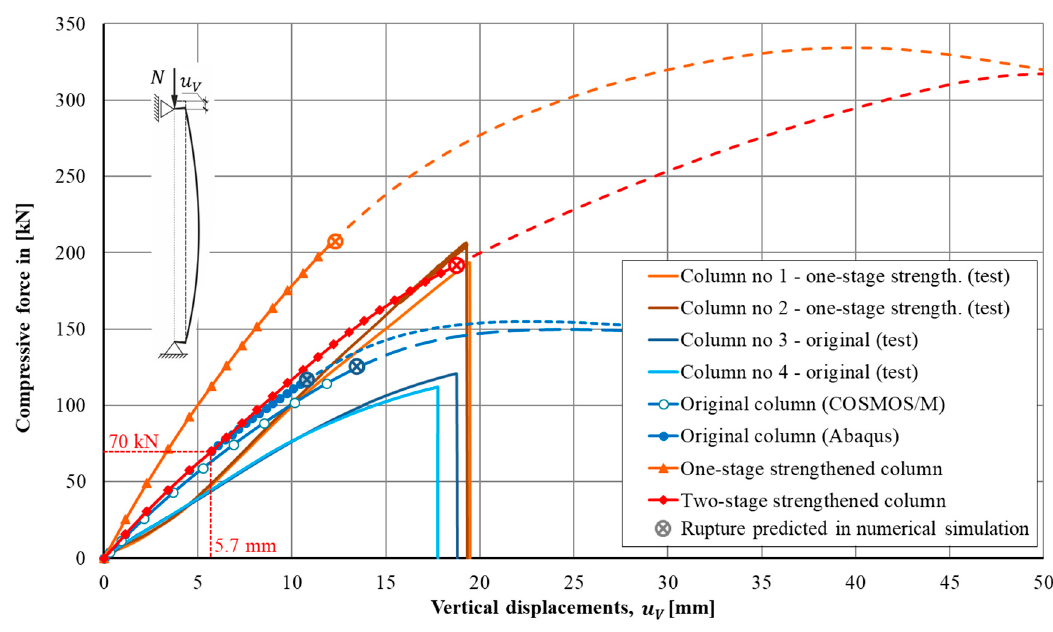
Figure 14. Nonlinear equilibrium paths obtained in experiments (cf. [23,24]) and in numerical simulations.